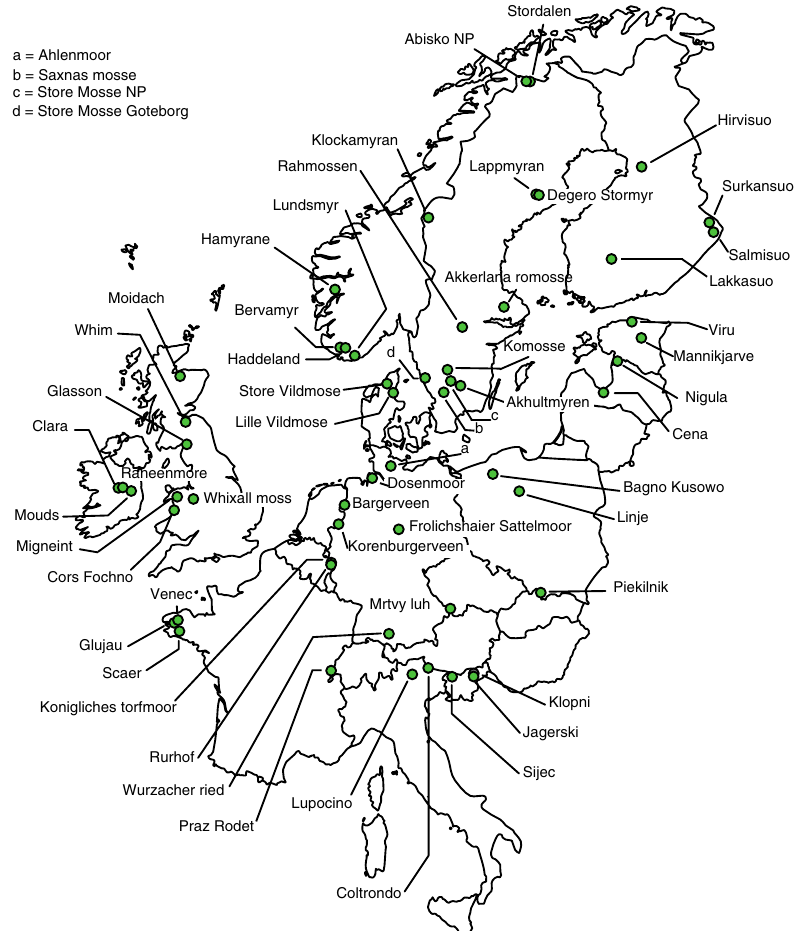
Fig. 1 Geographic locations of the 56 European peat bogs. Distribution of the sampled peat bogs across Europe. Map image source: R package